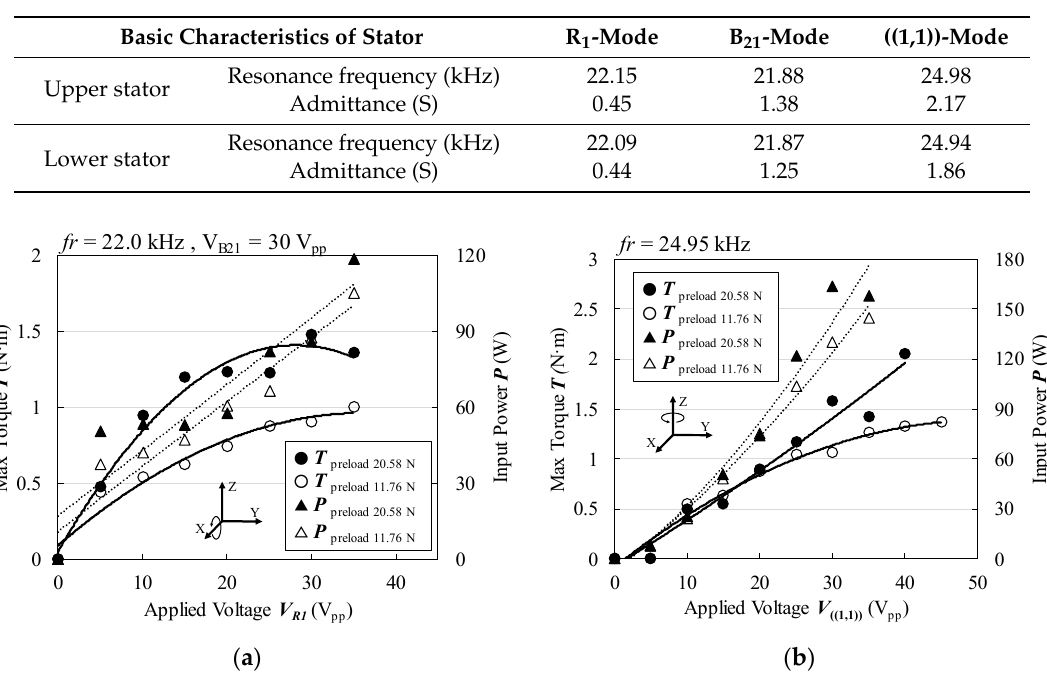
Figure 15. Maximum torque and electric input power with respect to applied voltage. ( a ) Rotation around X(Y)-axis and ( b ) Rotation around Z-axis. Table 3. Basic characteristics of stators with support ring attached.